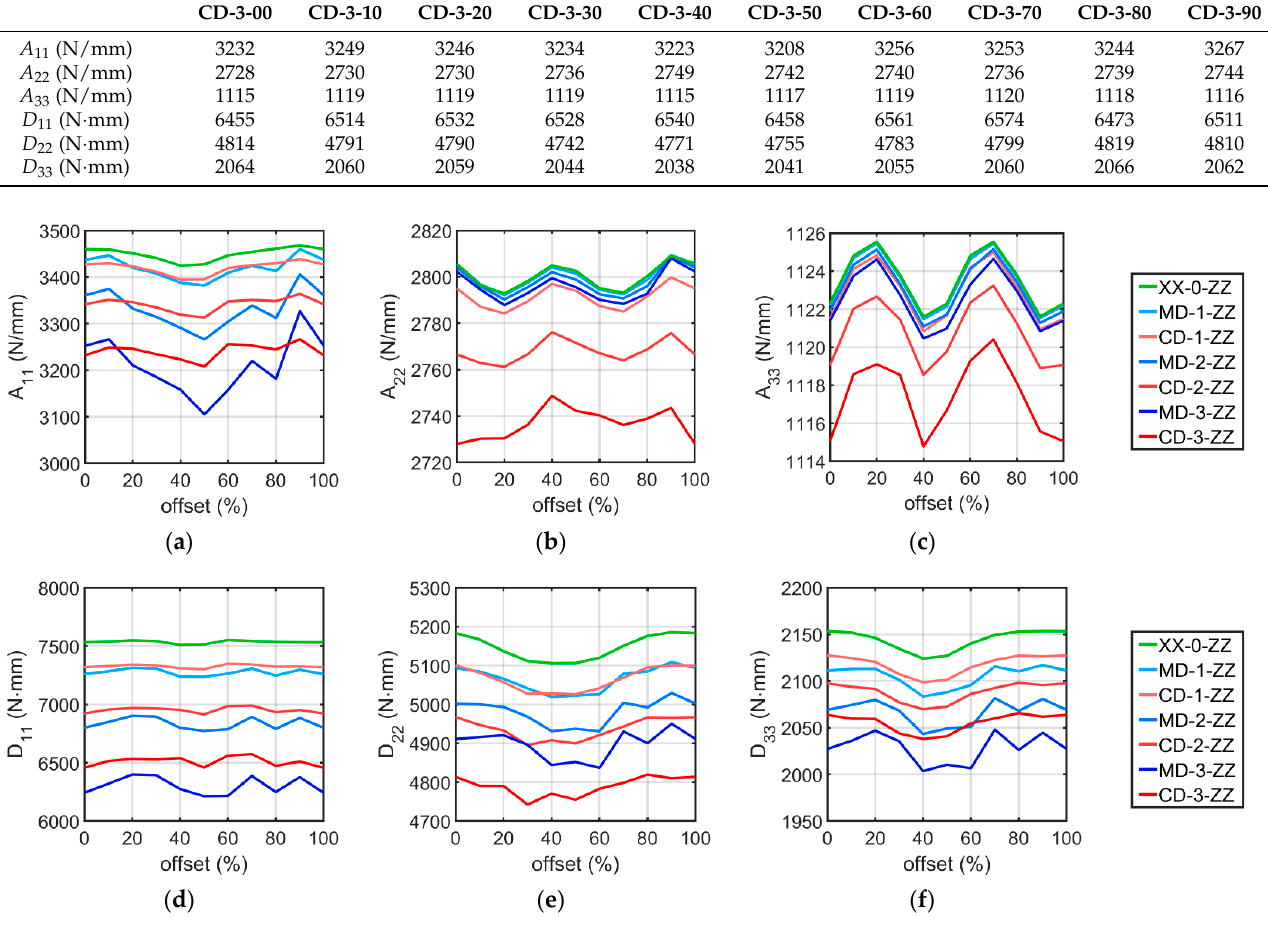
Figure 7. Influence of imperfections and offset on the cardboard stiffness of ( a ) A 11 , ( b ) A 22 , ( c ) A 33 , ( d ) D 11 , ( e ) D 22 , and ( f ) D 33 . For each shape and level of imperfection, the average stiffness values from all offset cases were calculated. Then, the obtained values for models with imperfections were compared to the average stiffnesses of perfectly shaped cardboard. In Figure 8, the tensile and bending stiffness reduction due to geometrical imperfections is shown.